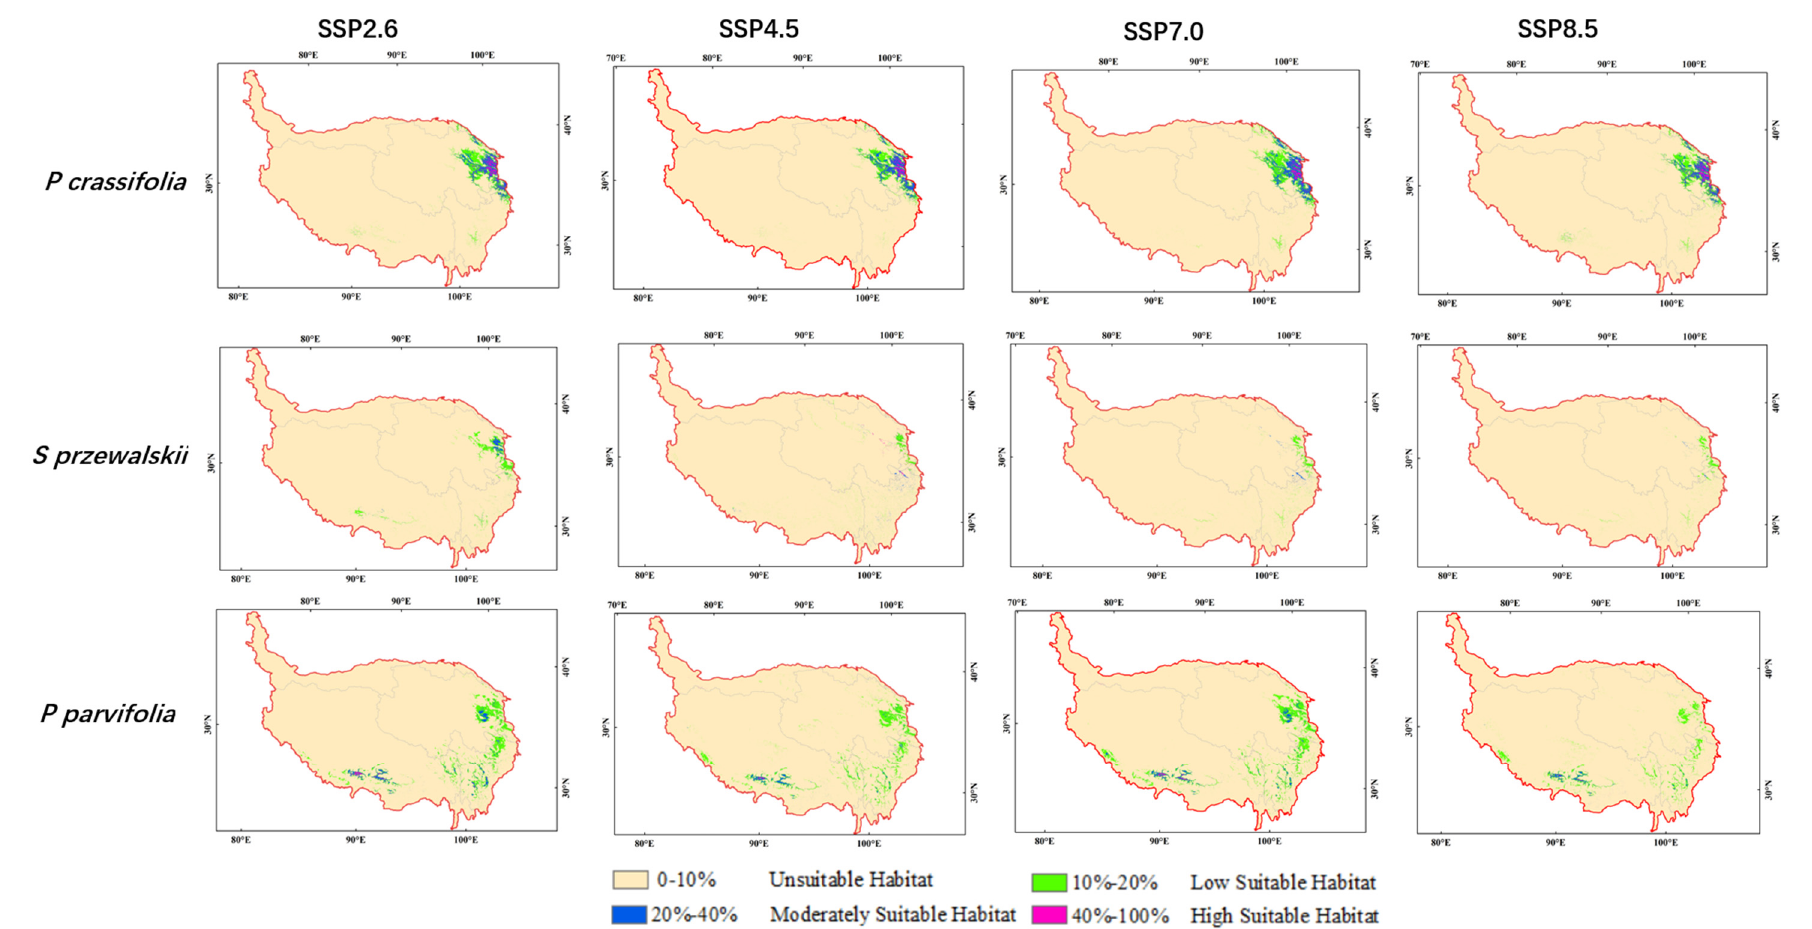
Figure 4. Prediction results of potential geographical distribution of three species in 2050s.